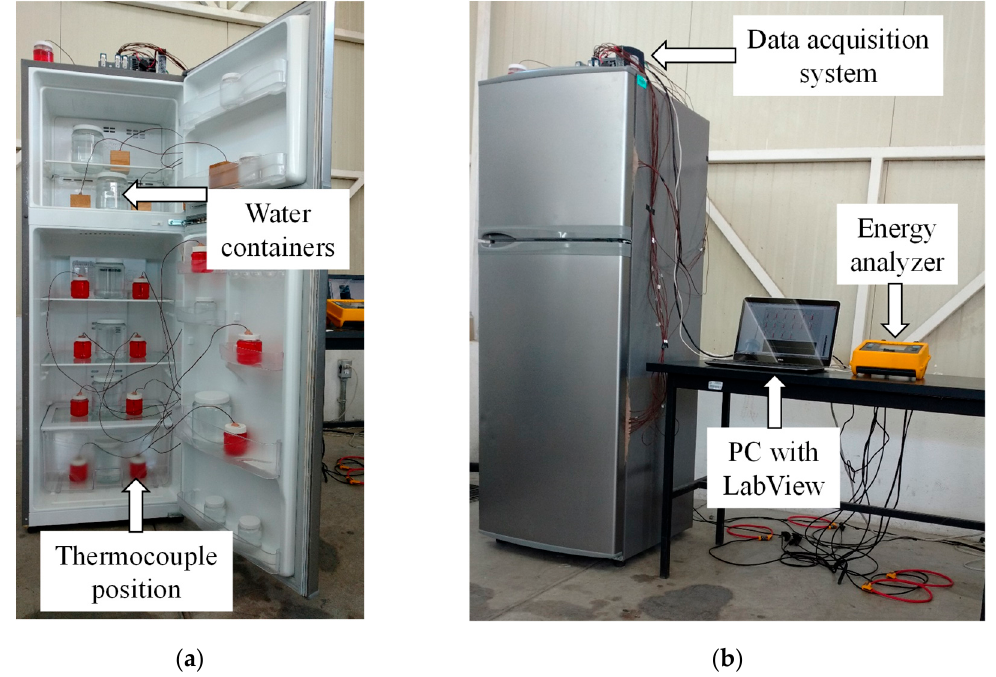
Figure 2. Experimental test bench: ( a ) temperature distribution; ( b ) instrumentation.